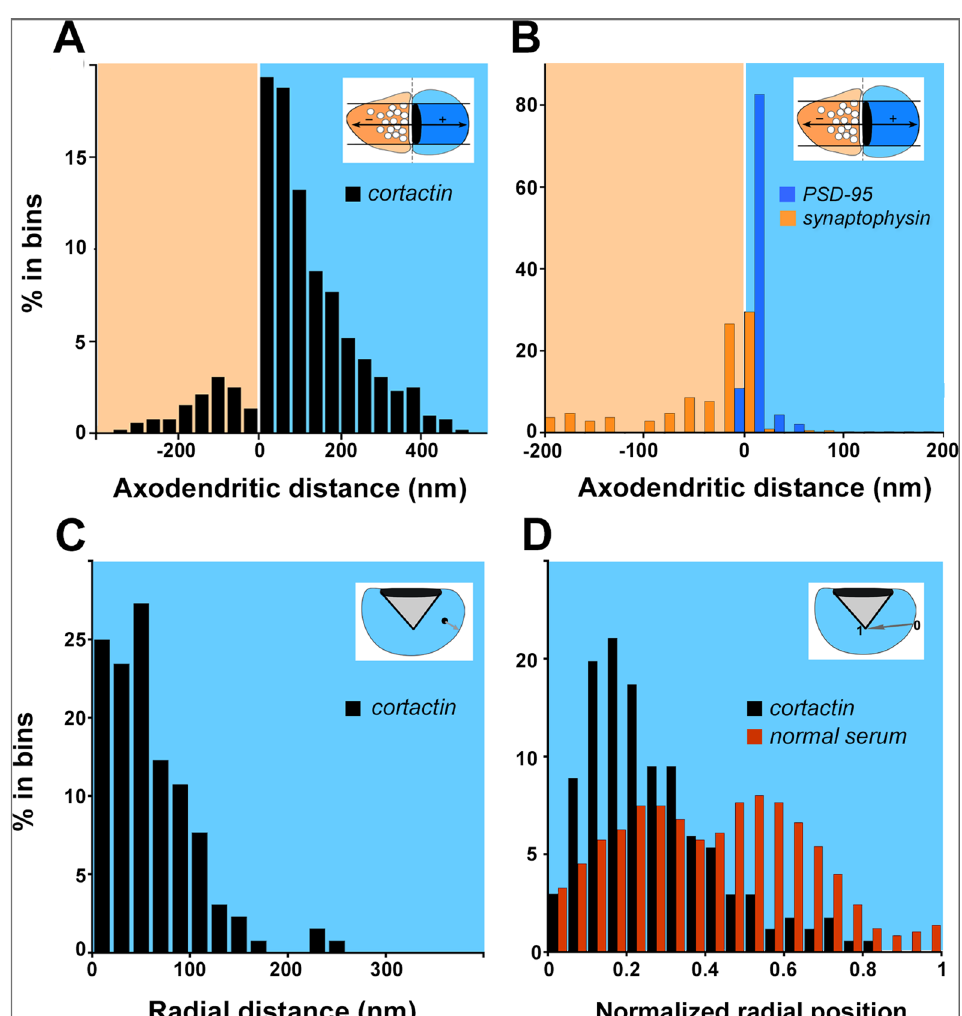
Figure 5. Distribution of cortactin, and other pre- and postsynaptic markers at PC-PF synapses. (A ) Graph showing the axo-dendritic distribution of gold particles coding for cortactin. Cortactin accumulated at the synapse, extending into the cytoplasmic fringe of the PSD. (See insets for explanation: orange shaded area is presynaptic, while blue is postsynaptic) ( B) Axo-dendritic distribution of gold particles coding for synaptophysin, and PSD-95. Synaptophysin concentrated presynaptically, while PSD-95 was highly restricted to the postsynapse. (See insets for explanation) ( C ) Radial distribution of particles coding for cortactin. Radial distances of gold particles coding for cortactin from the closest membrane of spine heads were shown in the graph as proportions. Most cortactin particles were found in the immediate vicinity of the non-synaptic membrane. ( D) Normalized distribution of cortactin shows that cortactin, independent of spine size, is restricted to the submembrane domain while particles from samples containing normal rabbit serum as control were found to be distributed more evenly within the spinoplasm. Data are from 195 profiles for cortactin, 45 for synaptophysin, and 45 for PSD-95. The bin width was 35 nm for (A) , 20 nm for (B,C ), and 0.05 normalized unit for (D) . In D data were smoothed with a three-point weighted running